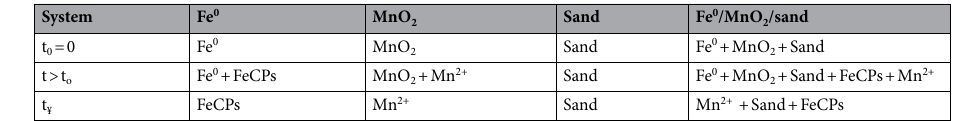
Table 2. Time dependent inventory of reactive species in the four investigated systems. t 0 corresponds to the start of the experiment, while t ¥ corresponds to Fe 0 depletion. It is assumed that MnO 2 is converted to Mn 2+ without impact on MB discoloration. FeCPs = Fe corrosion products. FeCPs can be free or coated on sand.